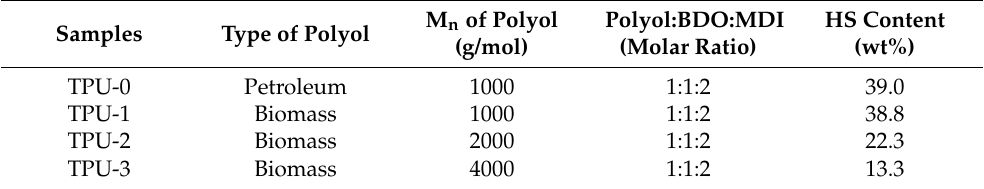
Table 1. Composition of TPUs synthesized with various